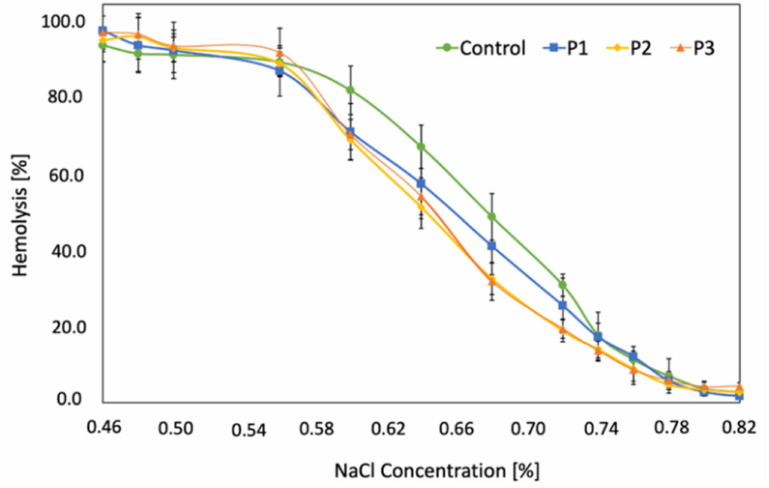
Figure 4. Hemolytic curves of control and cells interacted with P1, P2, and P3 liposome formulations used at a concentration of 50 µ M.